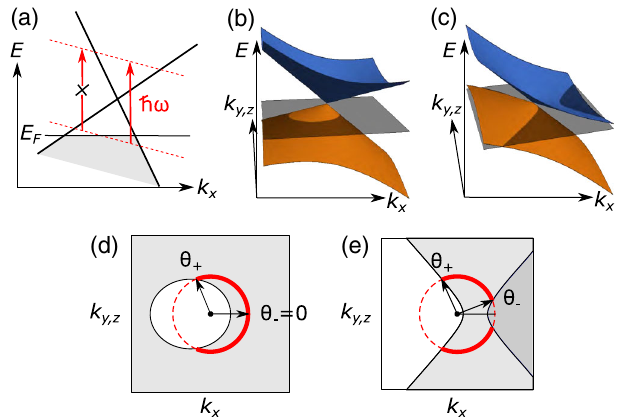
FIG. 1. Optical excitation near a tilted Dirac or Weyl cone. (a) Excitation of electrons by the absorption of a photon with frequency ω . (b) Type-I spectrum, j v 0 =v j < 1 . (c) Type-II spec- trum, j v 0 =v j > 1 . Here, v is the velocity of a Dirac or Weyl fermion at zero tilting, and v 0 is the overall velocity shift by μ → μ þ ℏ v 0 k , giving rise to a tilting of the cone. The gray x planes in panels (b) and (c) show the Fermi level. (d,e) Optically active region in momentum space for (d) type-I and (e) type-II cases. The small black dots at the center indicate the location of the gap-closing point. Red circles around the points show the − ℏ ω 2 ℏ vk , where k ¼ 0 at the surface satisfying ℏ ω ¼ ℏ ω c v ¼ gap closing. Both conduction and valence bands are unoccupied in the white region, only the valence band is occupied in the light gray region, and both bands are occupied in the gray region. Electrons can be optically excited only on the solid red arcs (i.e., θ θ < θ , where θ is the absolute value of the polar angle in − < þ either 2D or 3D), which is in the light gray